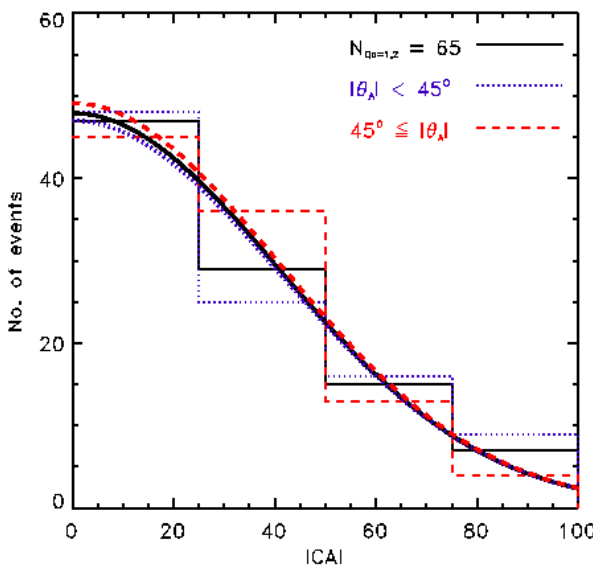
Fig. A1. Histograms of | CA | ( ≡ | Y O | / R O | (in %)), for Q O =1 and 2 combined split into those cases of | θ A | between 0 ◦ and 45 ◦ and those between 45 ◦ and 90 ◦ separately, as well as for the full set of N =65 cases. Curves of normal distributions are least-squares fitted to all three distributions, showing very similar properties.